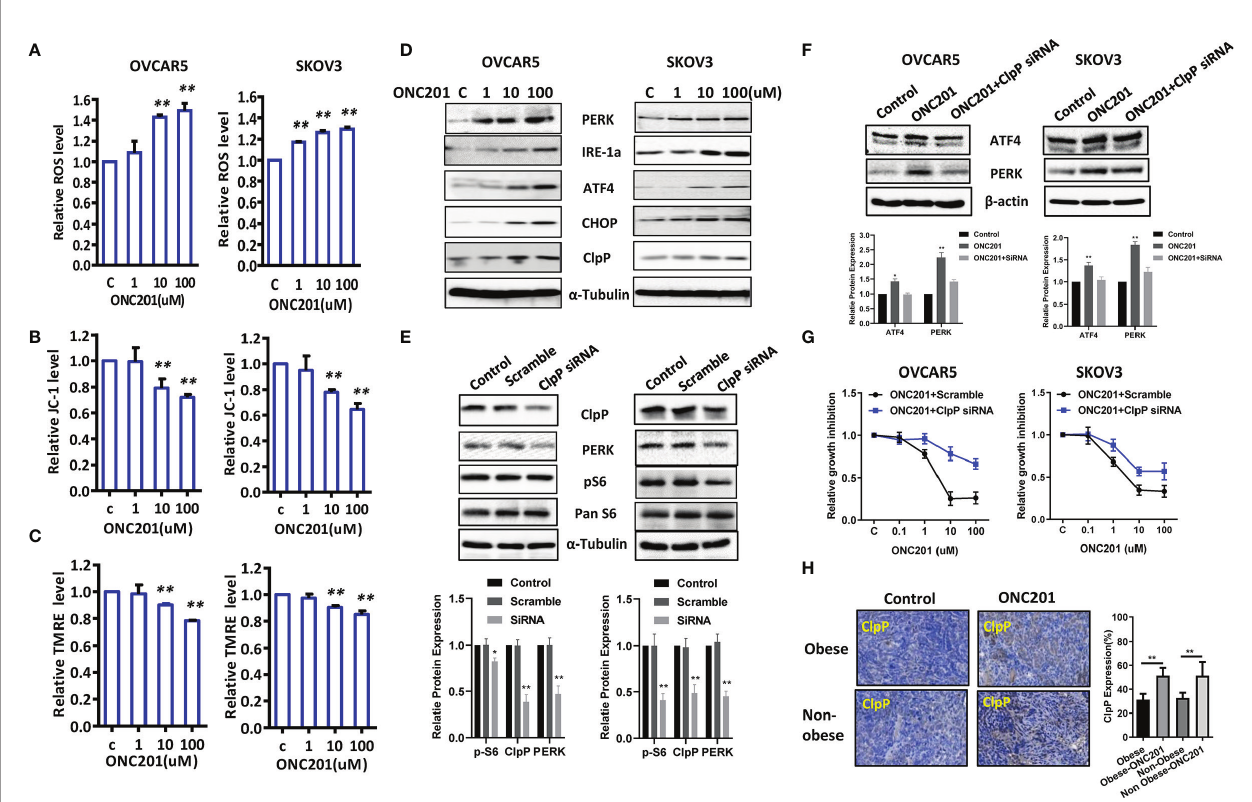
FIGURE 5 | ONC201 induced ER stress in OC cells. Cell stress analysis was done on OVCAR5 and SKOV3 cells treated with ONC201. ROS, JC-1 and TMRE products were measured by ELISA assays. ONC201 signi fi cantly increased the levels of ROS and decreased mitochondrial membrane potential in both cell lines compared to the vehicle -treated cells (A-C) . ONC201 increased the expression of cellular stress related proteins including PERK, IRE-1a, ATF4, CHOP and ClpP in both cell lines after 24 hours of treatment (D) . Knockdown ClpP reduced the expression of PERK and phosphorylated S6 in both cells (E) . ClpP siRNA decreased ONC201 mediated ATF4 and PERK expression and ONC201 induced cell inhibition in both cells (F, G) . In KpB mice, ONC201 also induced ClpP expression in the ovarian tumors under obese and lean conditions, as measured by IHC (H) . * <0.05, **